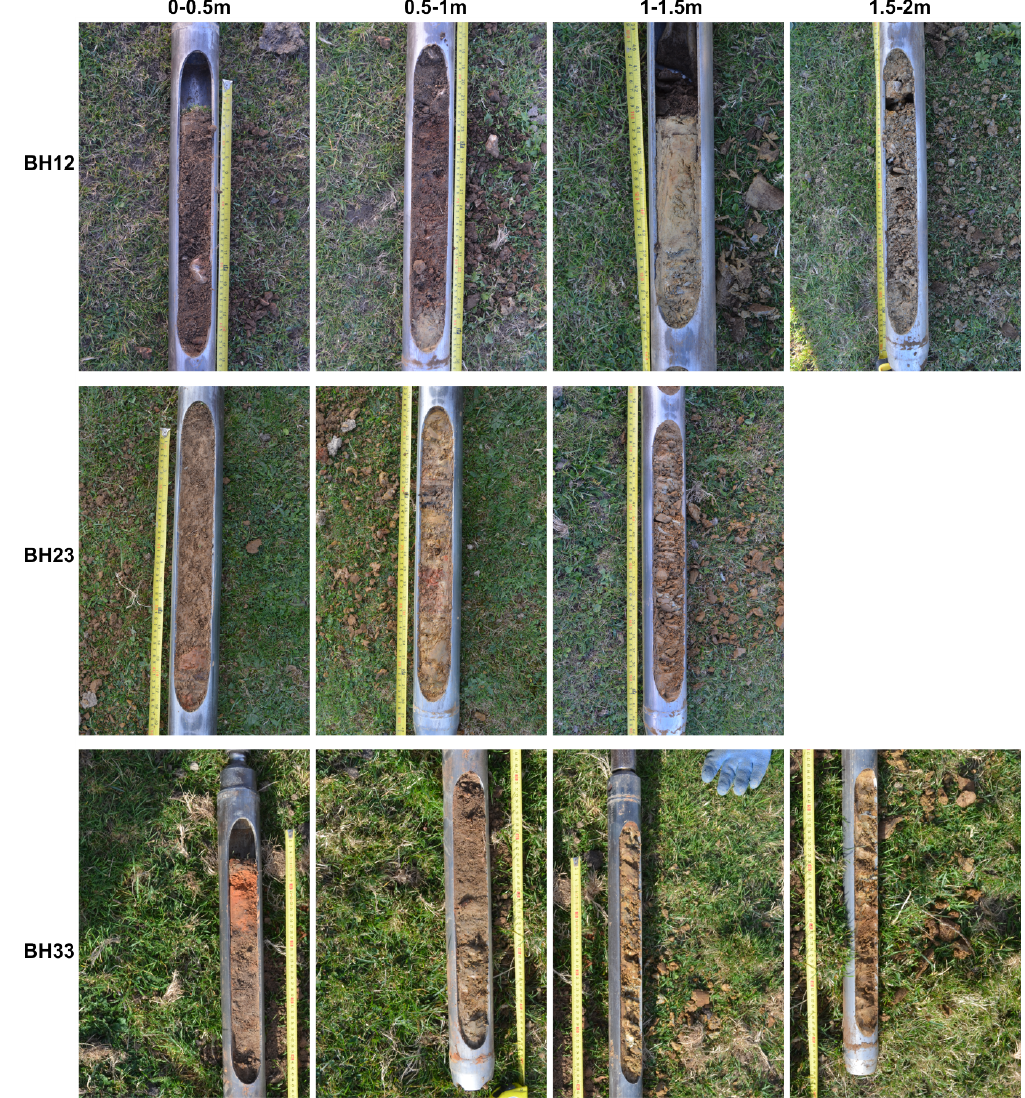
Figure 10. Pictures of the sediments extracted in the cores BH12, BH23 and